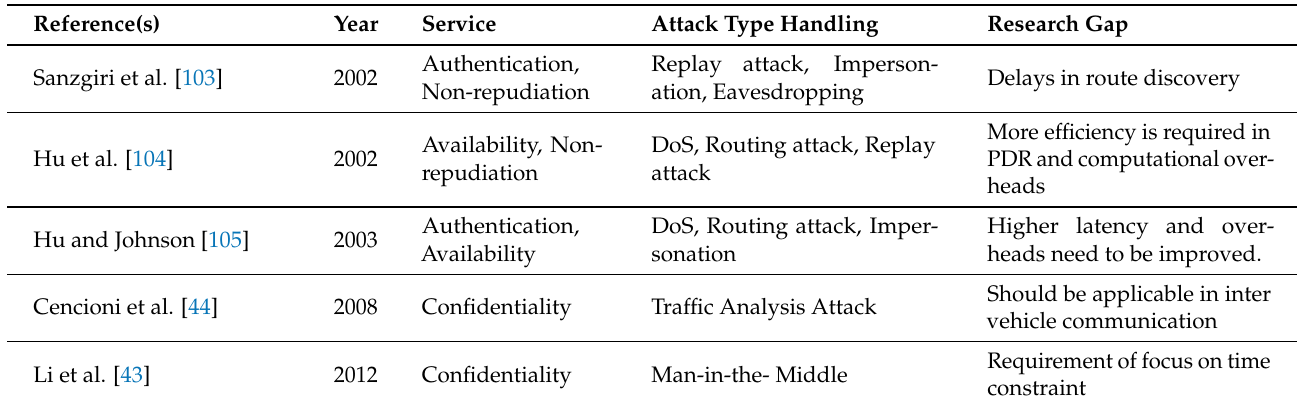
Table 6. Authentication and authorization techniques for